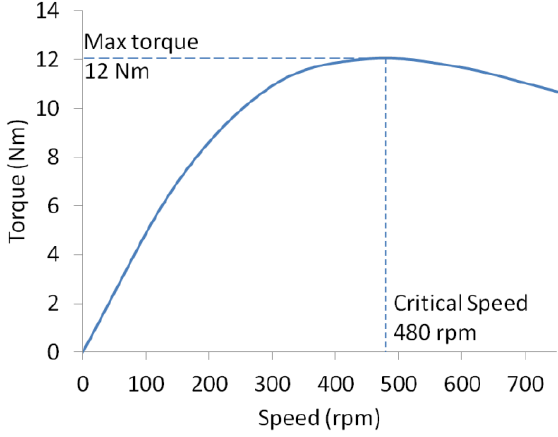
Figure 4. 3D finite element method (FEM) braking torque.